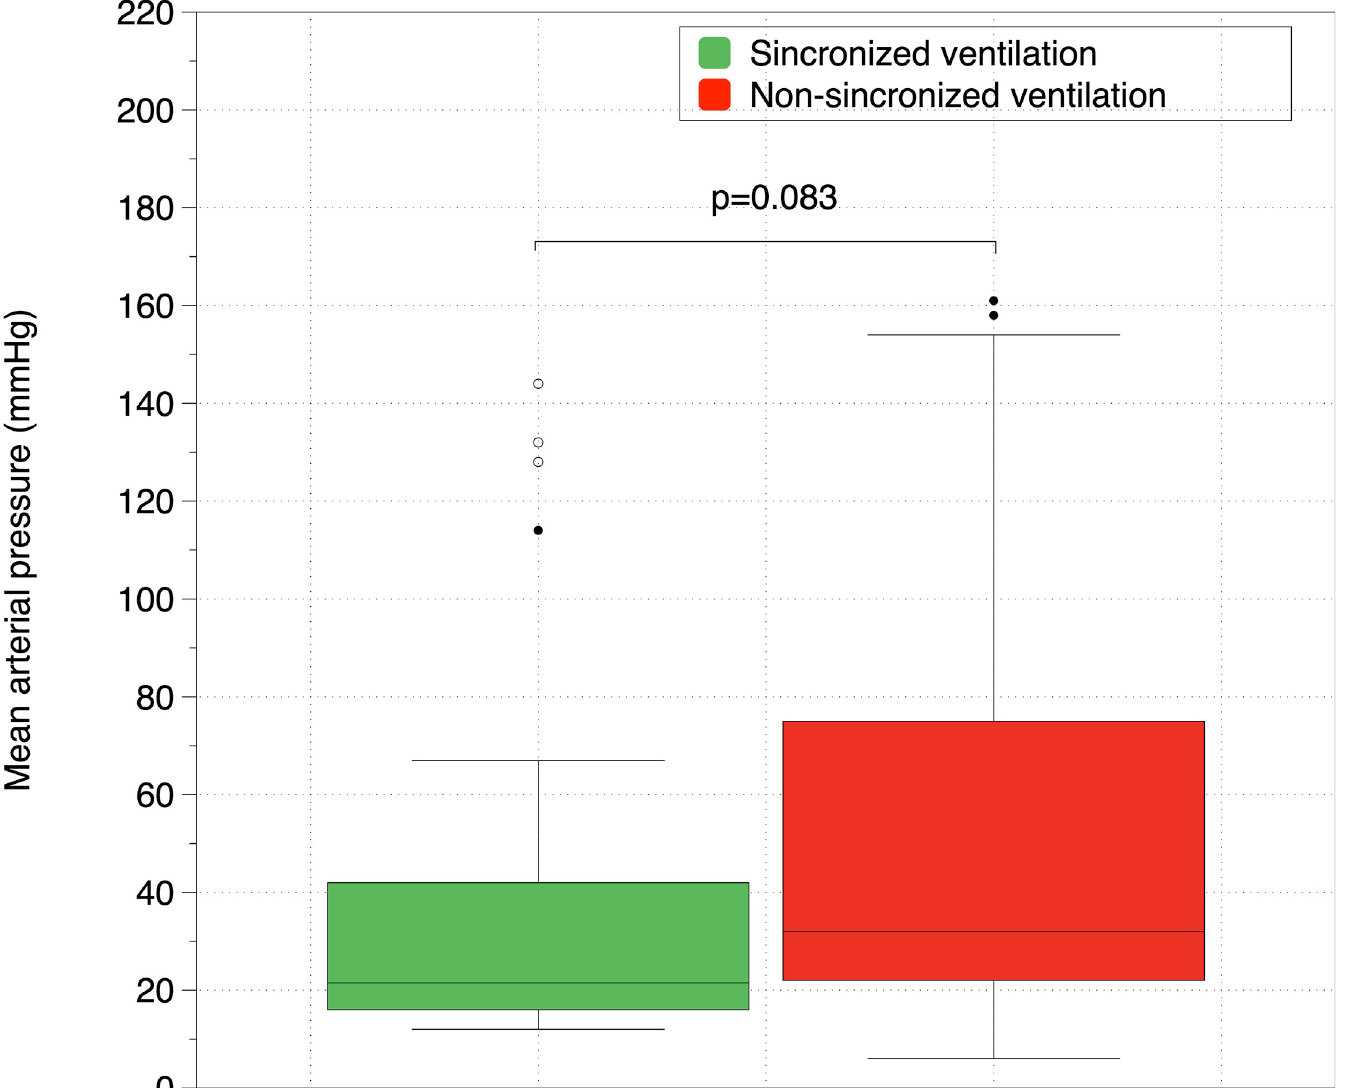
Fig 4. Comparison of Mean Arterial Pressure (mmHg) between synchronized and non- synchronized